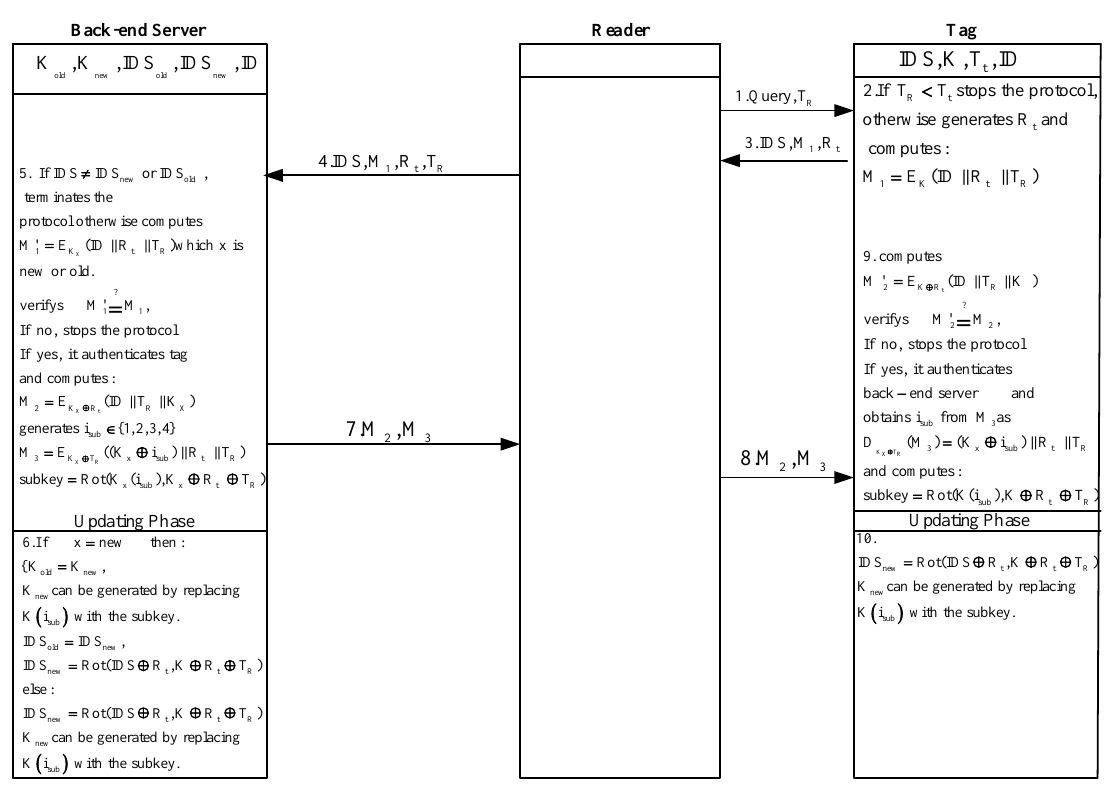
Figure 3. The UEAP